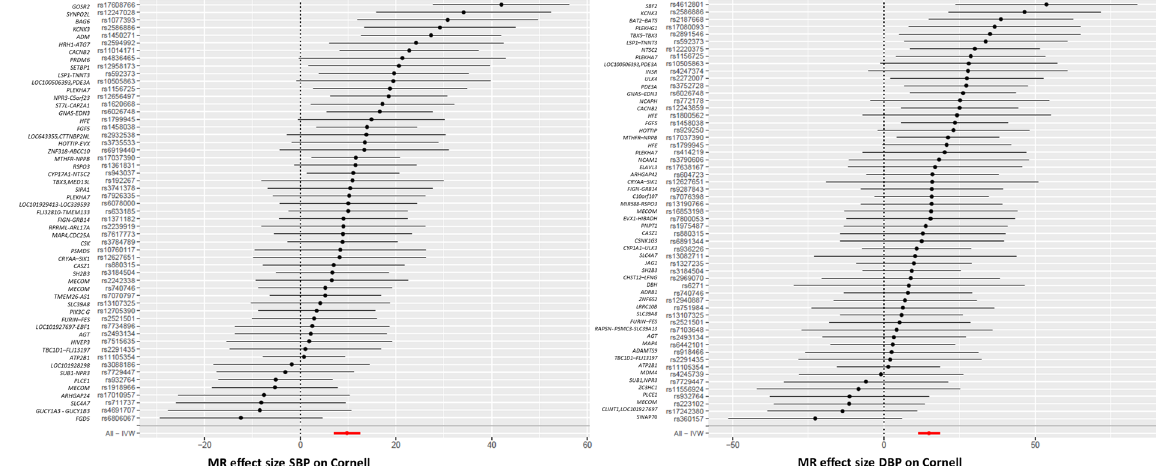
Figure 2. Forest plots: SBP and DBP associated with ECG Cornell criteria. On the X-axis the Mendelian Randomization effect size of blood pressure on Cornell product were displayed. On de Y-axis the different genetic variants were listed. DBP = diastolic blood pressure, MR = Mendelian randomization, SBP = systolic blood pressure.